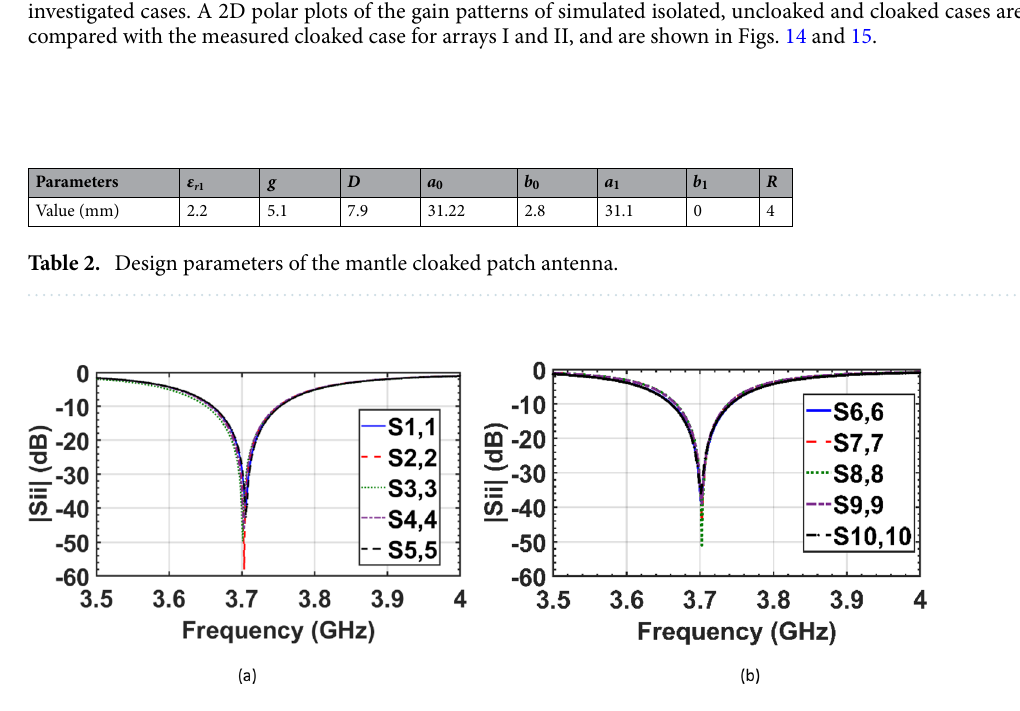
Figure 6. Simulated reflection coefficients of elements of the ( a ) isolated array I, and ( b ) isolated array